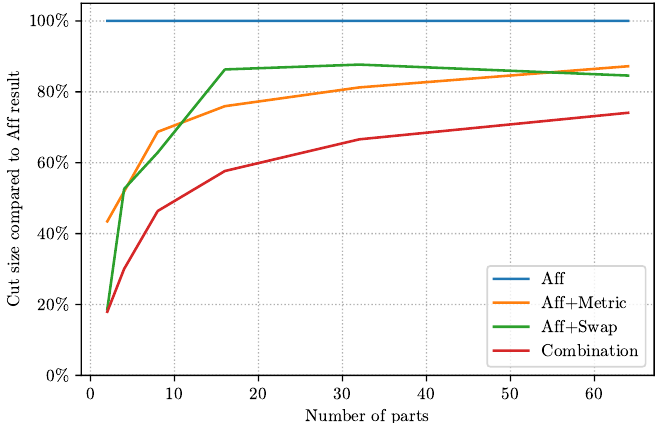
Figure 6. Comparison of the (fully balanced) cut size for three semilocal operations on Twitter . The results are compared to AffCommNeigh , set as 100%.